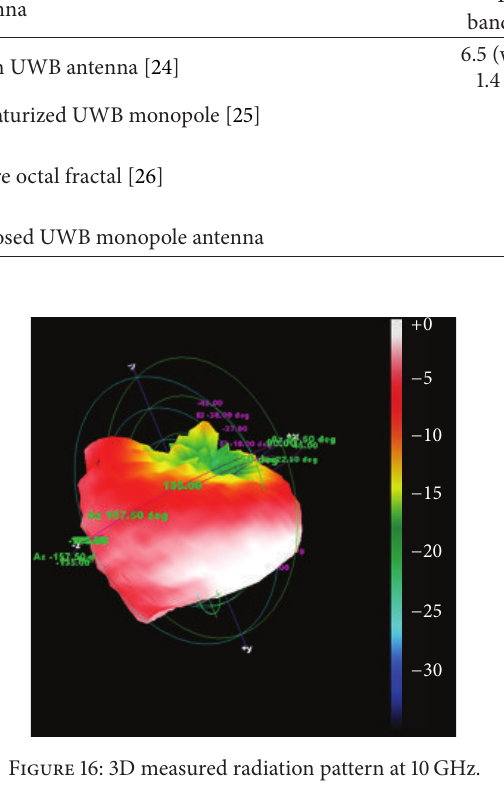
pattern is characteristic of monopole antenna. This feature is depicted in radiation patterns of proposed monopole fractal antenna. Horizontal, vertical cuts, and 3D plots of measured radiation pattern for frequency of 10 GHz are shown in Figures 14, 15, and 16,